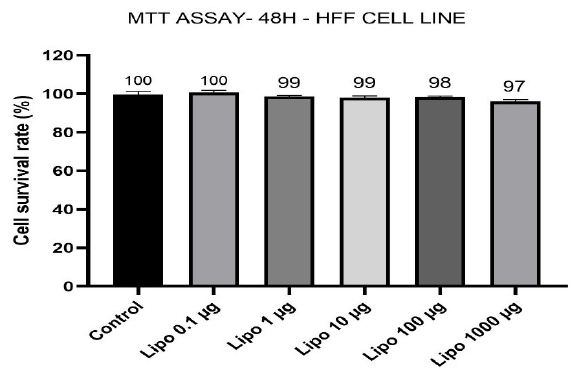
Figure 9 . Obtained Results From MTT Regarding Treatment of HFF Cells With Different Concentrations of Empty Synthesized Liposomes After 48